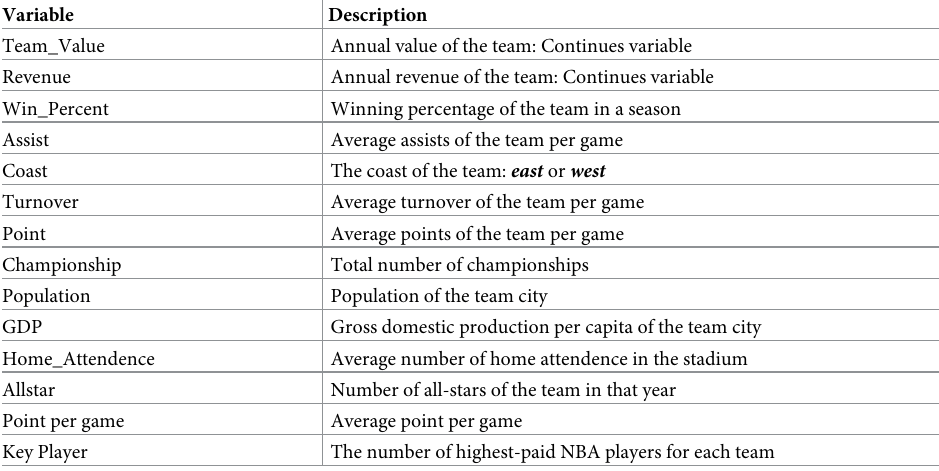
Table 1. Variables and their descriptions.